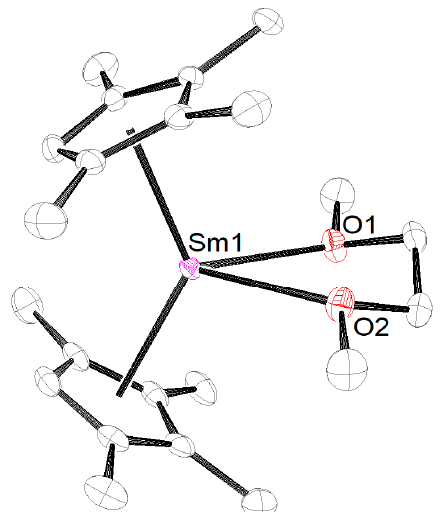
Figure 1. ORTEP representation of complex 2 with selective atom labeling. Ellipsoids are drawn at the 50% probability level. For clarity, hydrogen atoms and the second molecule in the asymmetric unit are not shown.